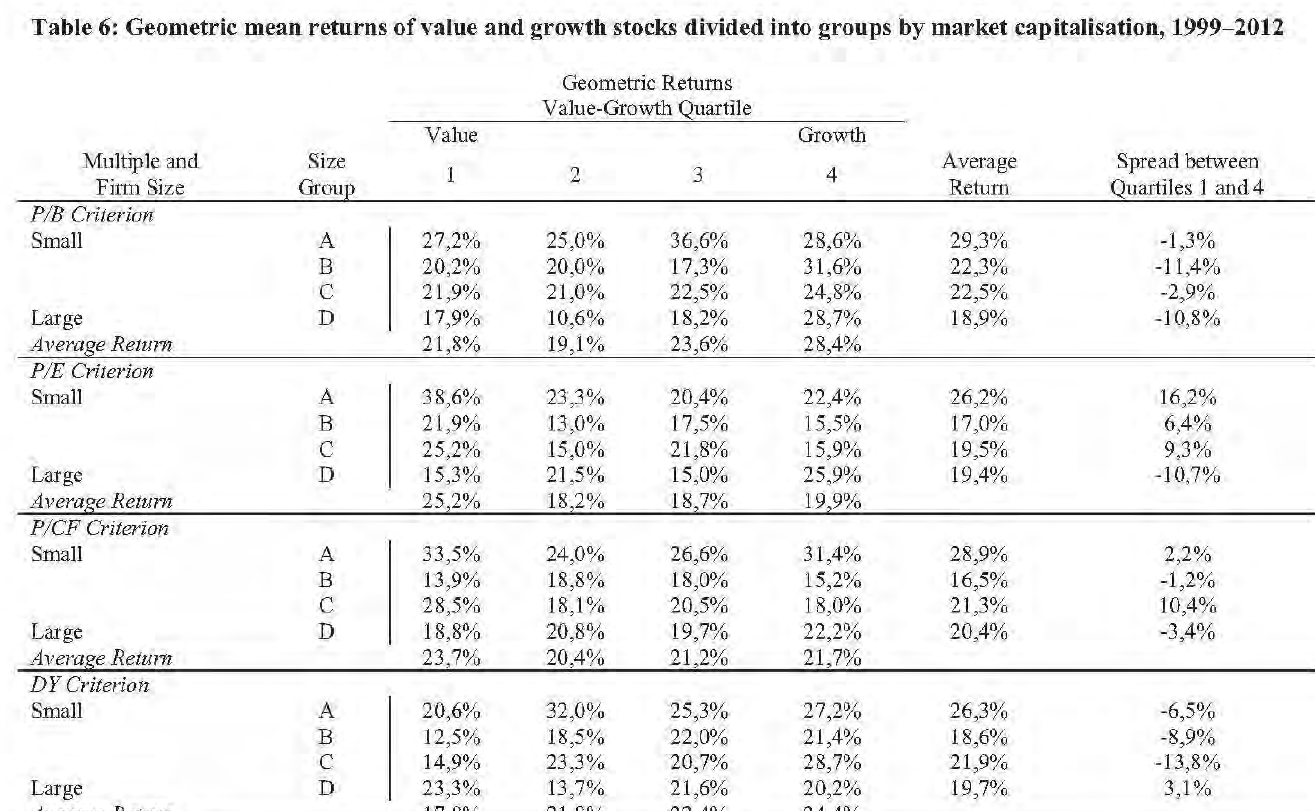
Geometric Returns Value-Growth Quartile Value Growth Average Spread between Quartiles 1 and